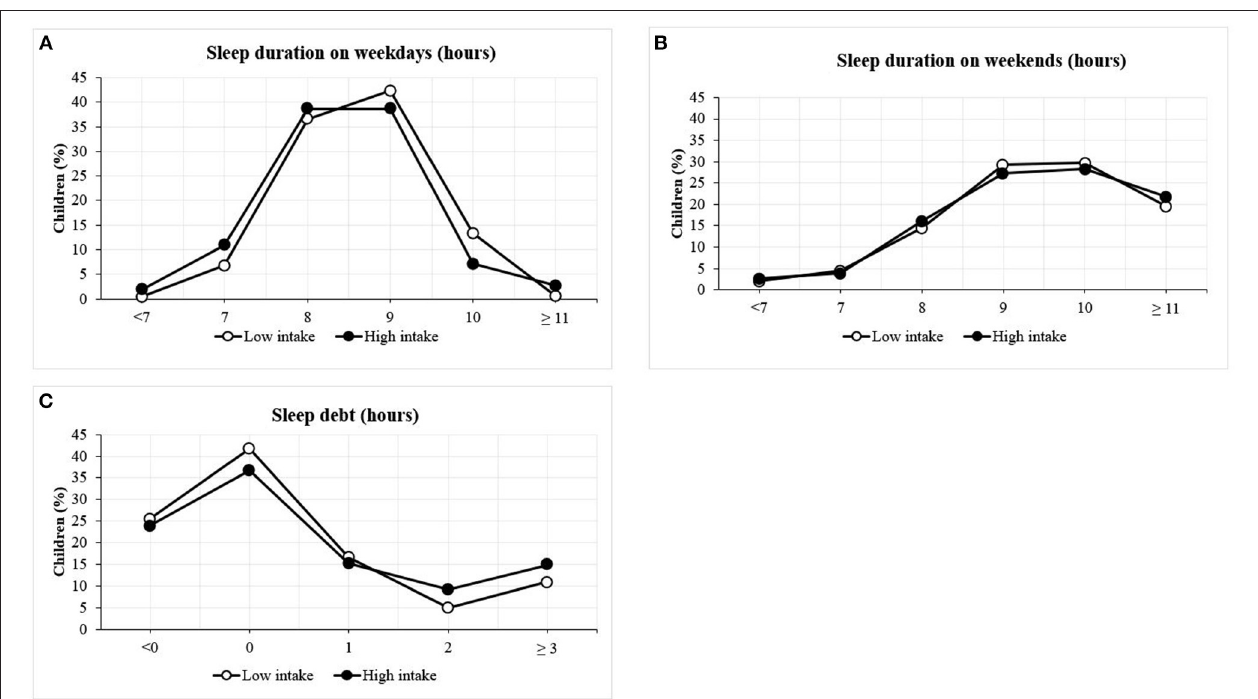
FIGURE 3 | Distribution of sleep duration according to SSBs intake among children. (A) Sleep duration on weekdays; (B) sleep duration on weekends; (C) sleep debt.